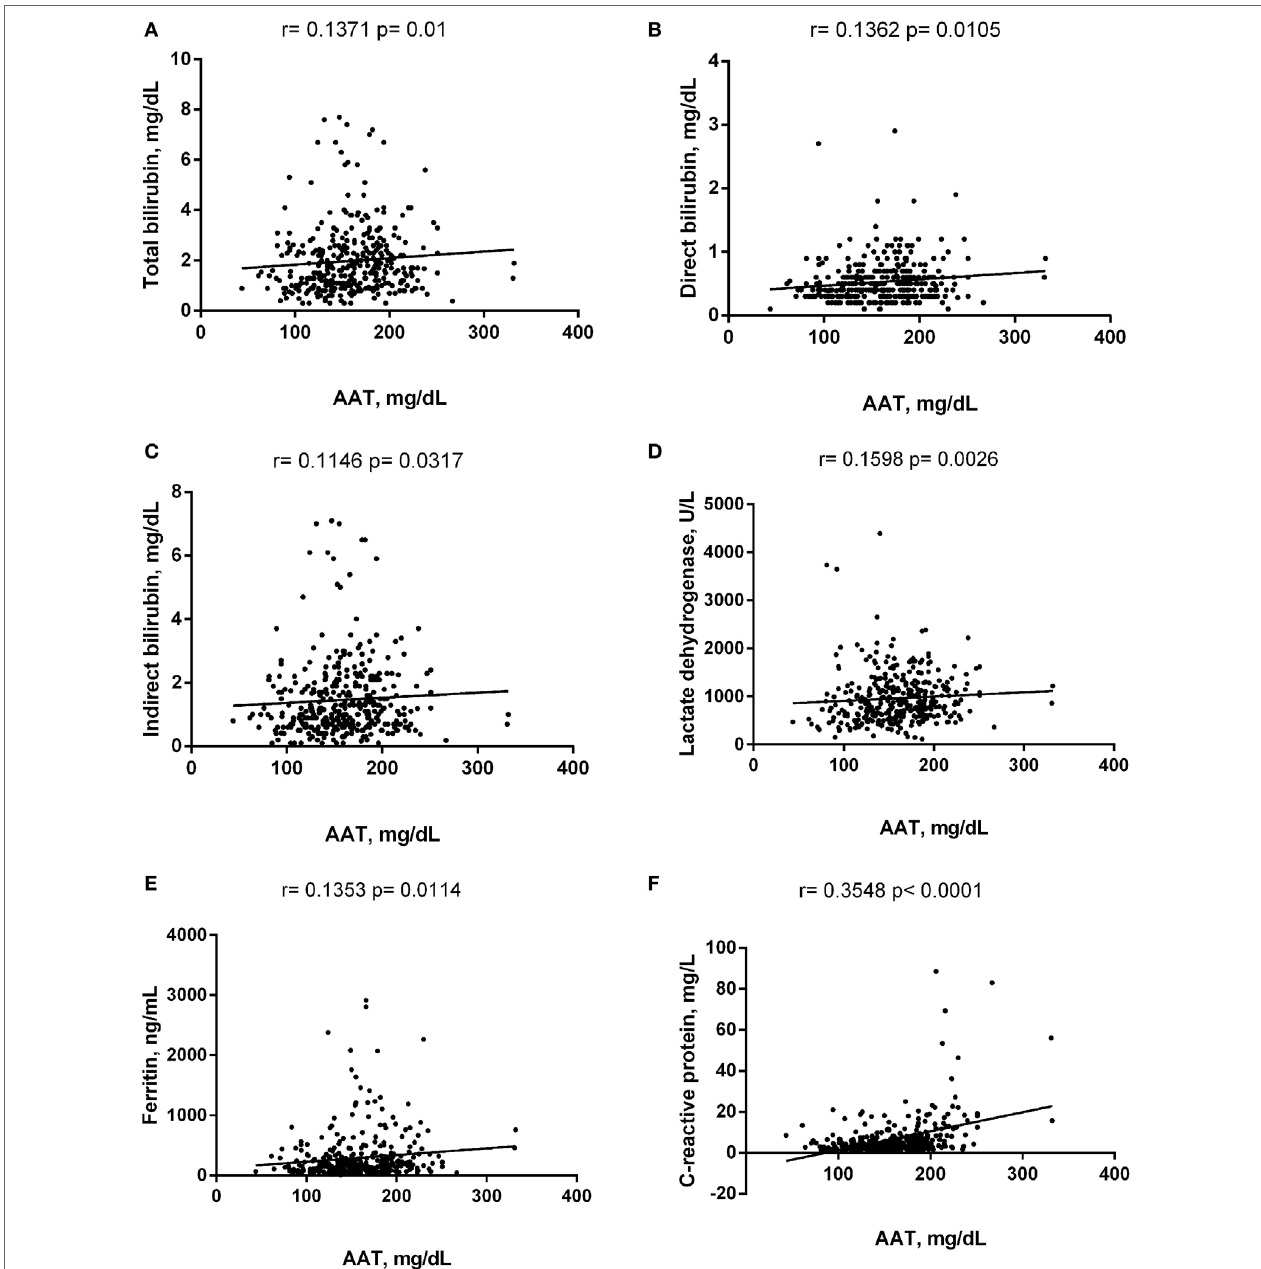
FigUre 4 | Positive correlations of alpha-1 antitrypsin (AAT) with biochemistry markers in steady-state sickle cell disease patients. (a) Total bilirubin; (b) direct bilirubin; (c) indirect bilirubin; (D) lactate dehydrogenase; (e) ferritin; (F) C-reactive